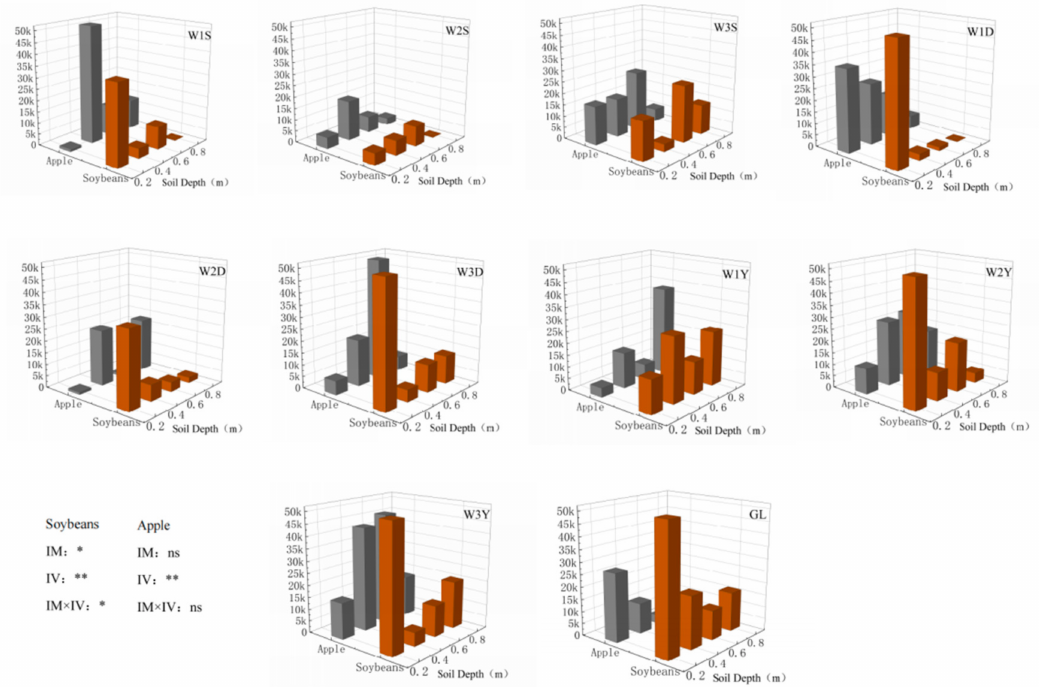
Figure 7. Soybean and apple vertical root length density diagram. Note: * indicates significant correlation ( p < 0.05); ** is highly significant ( p < 0.01);ns is insignificant correlation ( p > 0.05). IM is irrigation method and IV is irrigation